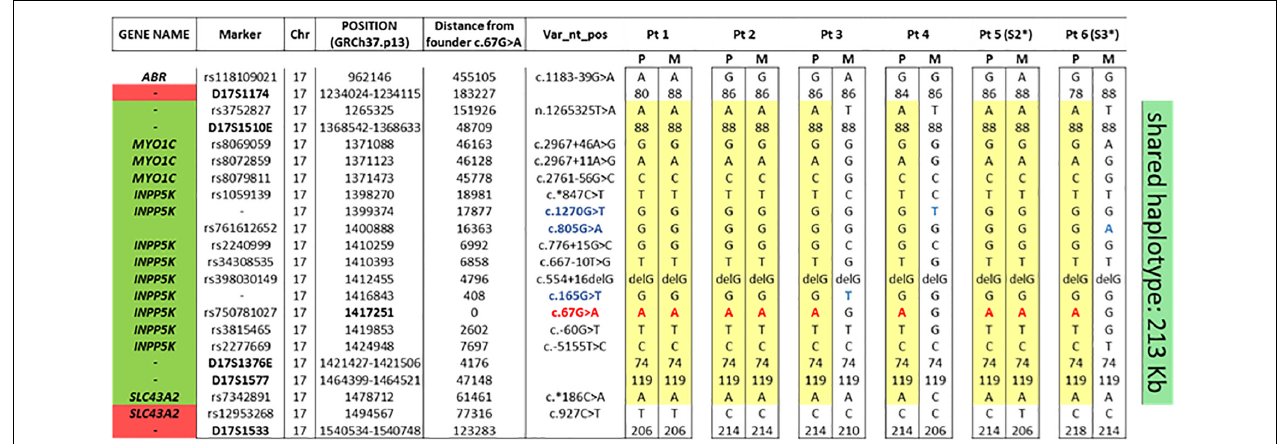
FIGURE 2 | The common haplotype showing the minimal common region among the six patients. As can be seen, the nine alleles with the INPP5K c.67G > A variant (in red) shared a common region between rs3752827 and rs7342891 (213 kb). In blue, the other three INPP5K variants in compound heterozygosis with the founder c.67G > A variant. Segregation analysis in both parents of the six patients allowed to reconstruct parental genotype. P , paternal allele; M , maternal allele. * Patient already reported by Osborn et al.